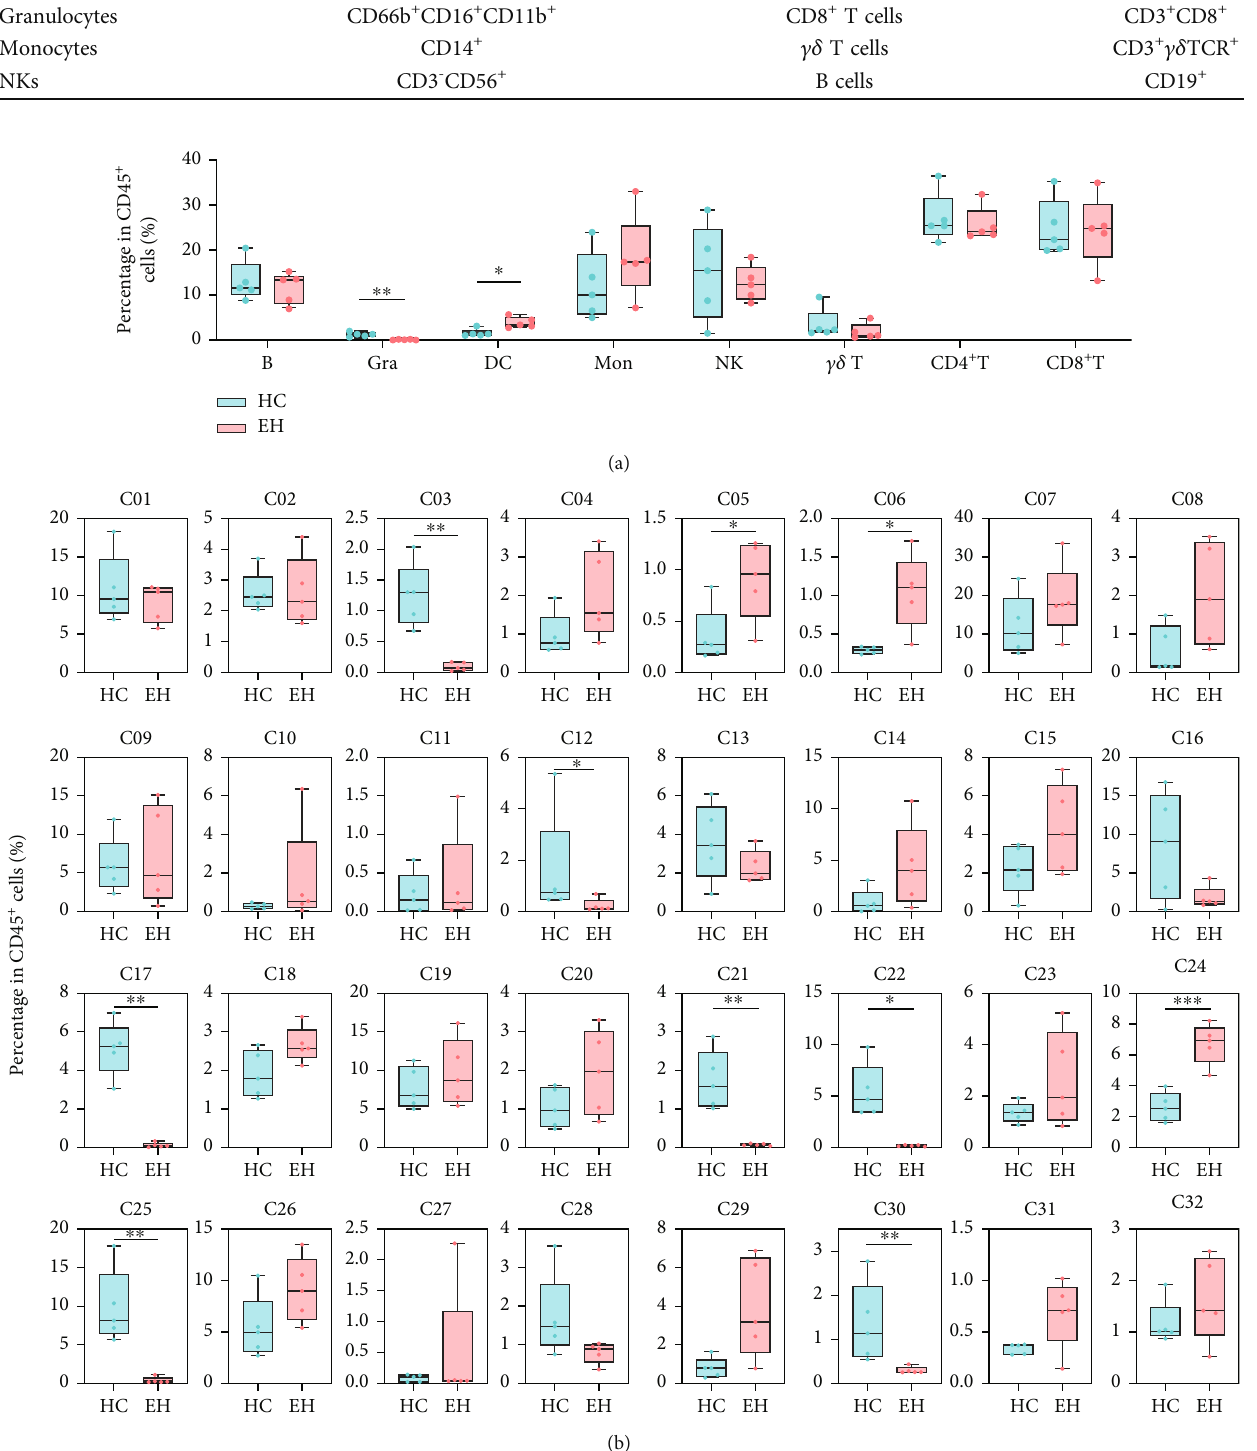
Figure 2: The percentage of di ff erent cell subsets in the HC and EH groups. (a) Percentage comparison of DCs, monocytes, granulocytes, NKs, CD4 + T cells, CD8 + T cells, γδ T cells, and B cells between the two groups. (b) The percentage di ff erence of 32 cell subsets between the two groups. ∗ P < 0 : 05 , ∗∗ P < 0 : 01 , ∗∗∗ P < 0 : 001 .